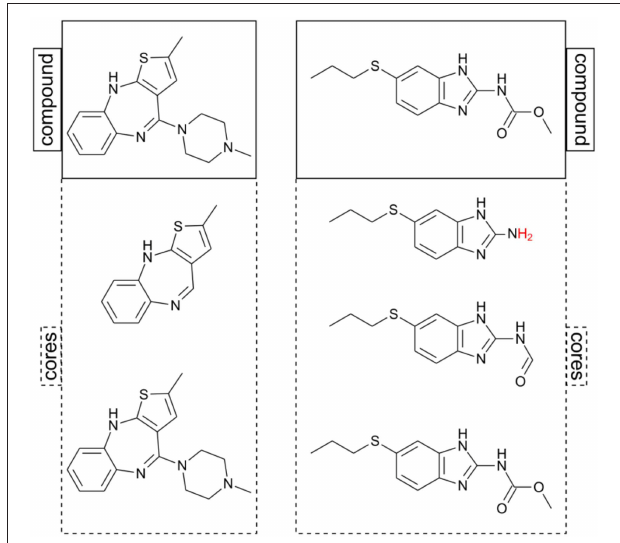
FIGURE 2 | Two examples of putative cores computed for two molecules. Note that in this approach the same chemical structure can be its own core (structures at the bottom). After RECAP fragmentation, hydrogens are added to the core structure to avoid invalid valence (marked in red).